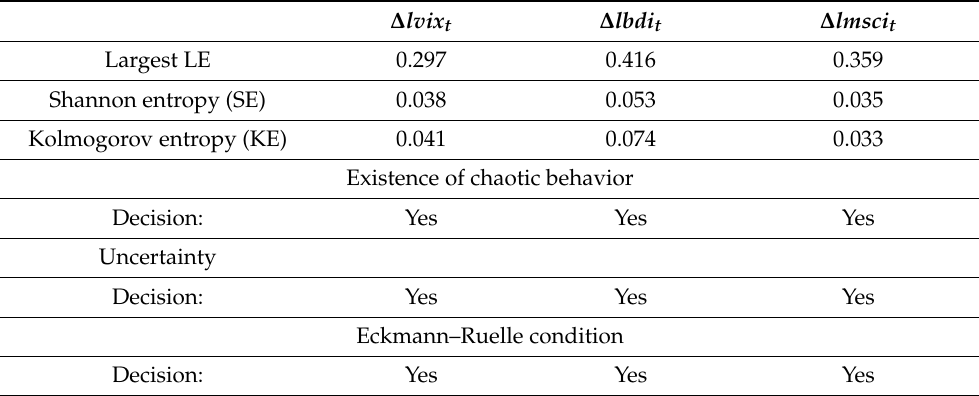
Table 4. Chaotic Behavior Test